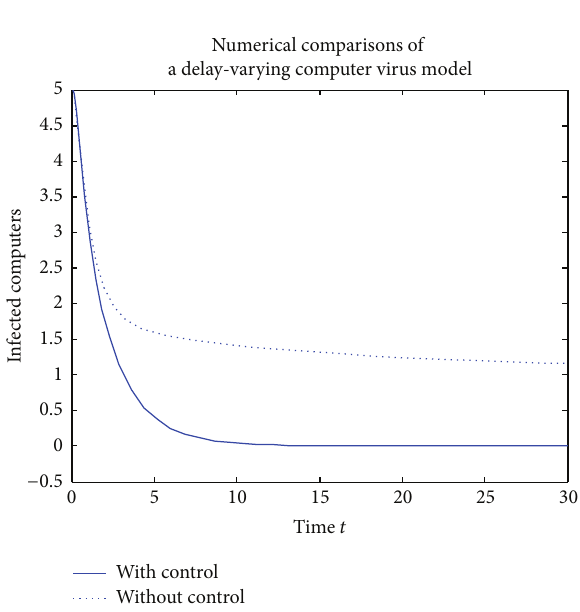
Figure 2: Infected computers (with and without control) versus time 𝑡